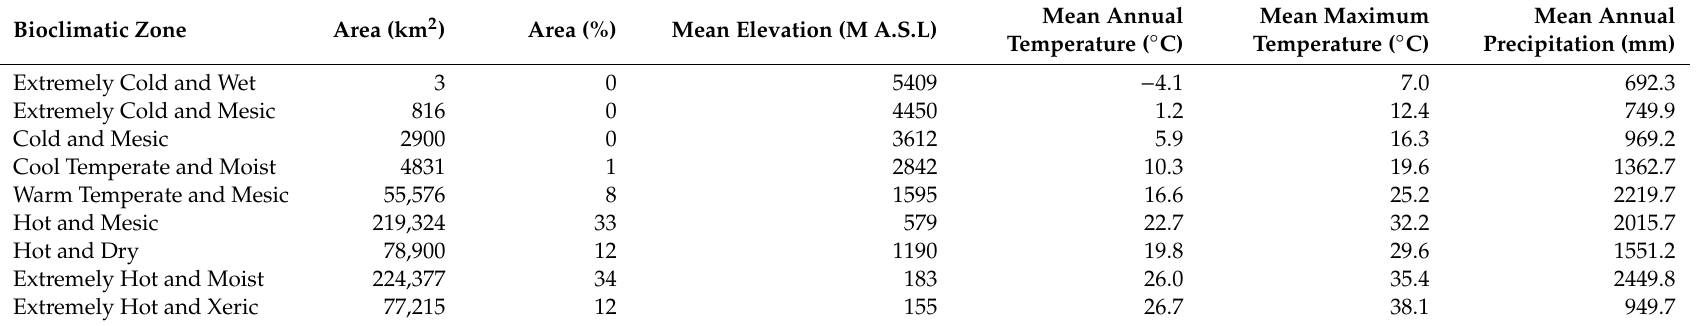
Table 1. Characteristics of the bioclimatic zones in Myanmar based on climate data from 1960 to 2000.